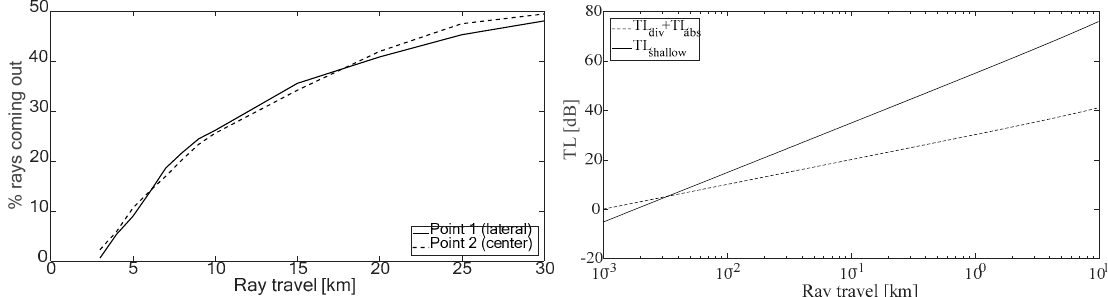
Figure 12. ( left ) Percentage of rays that left the port. ( right ) Comparison of transmission losses with different propagation models.